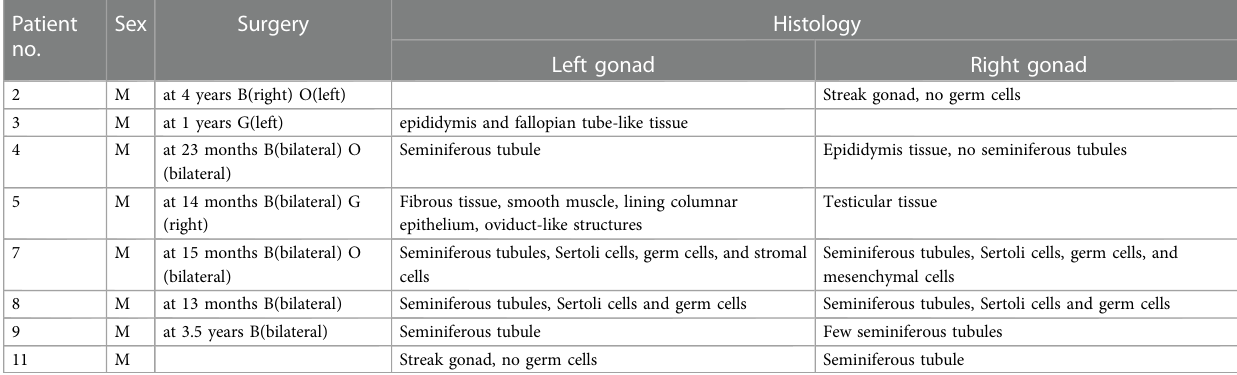
TABLE 7 Histological fi ndings in patients who underwent surgical exploration and/or gonadectomy. Patient